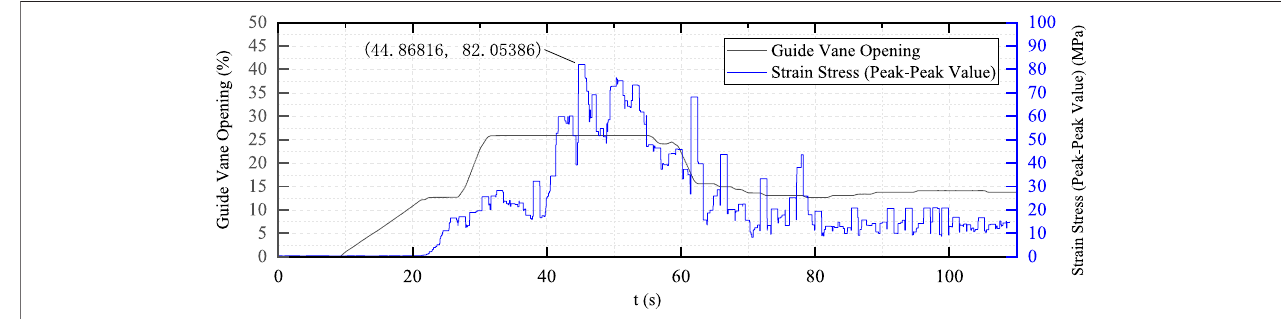
FIGURE 13 | The dynamic strain – stress curve with the guide vane opening (two-stage acceleration).